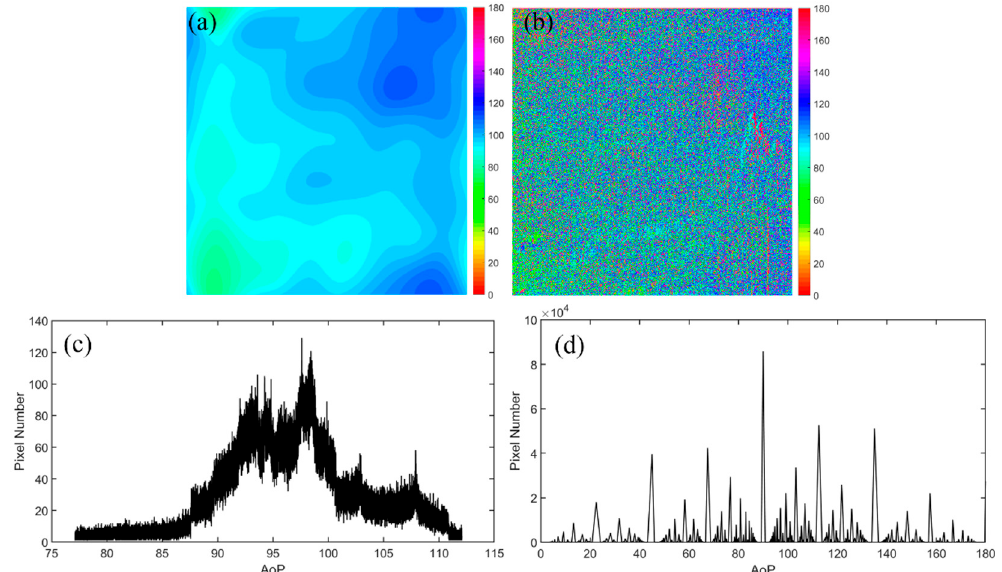
Figure 3. The AoP distribution of the hazy images: ( a ) after low-pass filtering and ( b ) before low-pass filtering. Statistical distribution: ( c ) after and ( d ) before low-pass filtering.